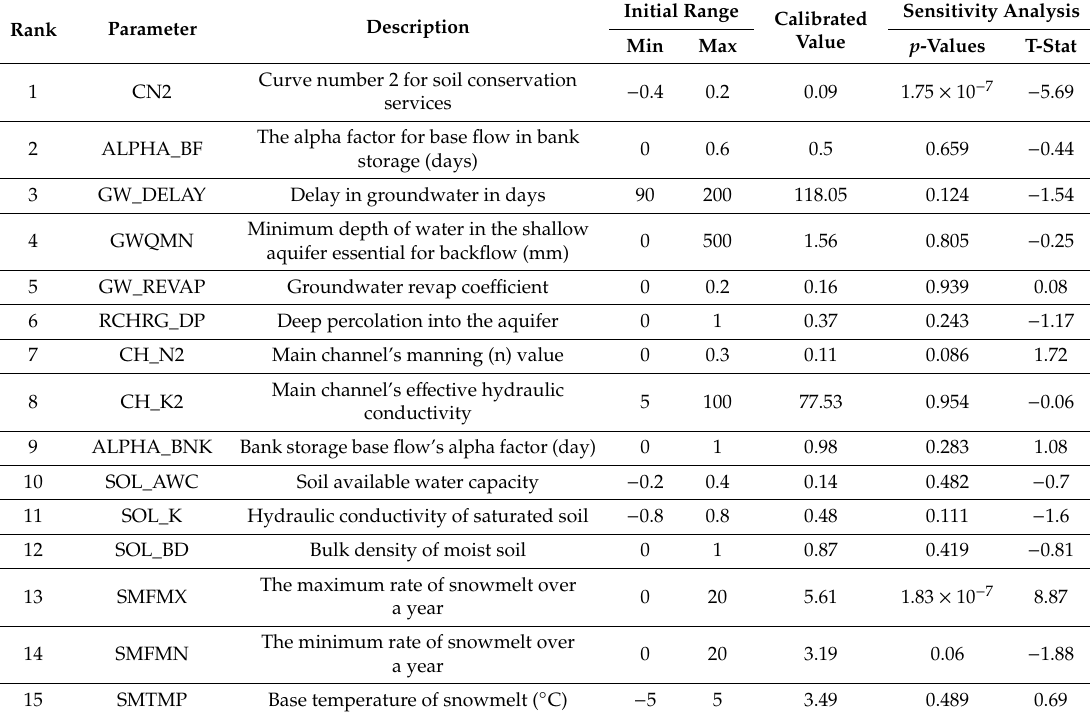
Table 5. Results of calibration and validation using the SUFI-2 algorithm.